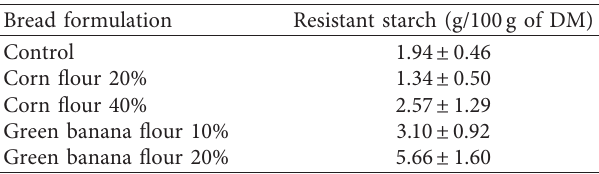
Table 5: Resistant starch content of breads with partial wheat flour